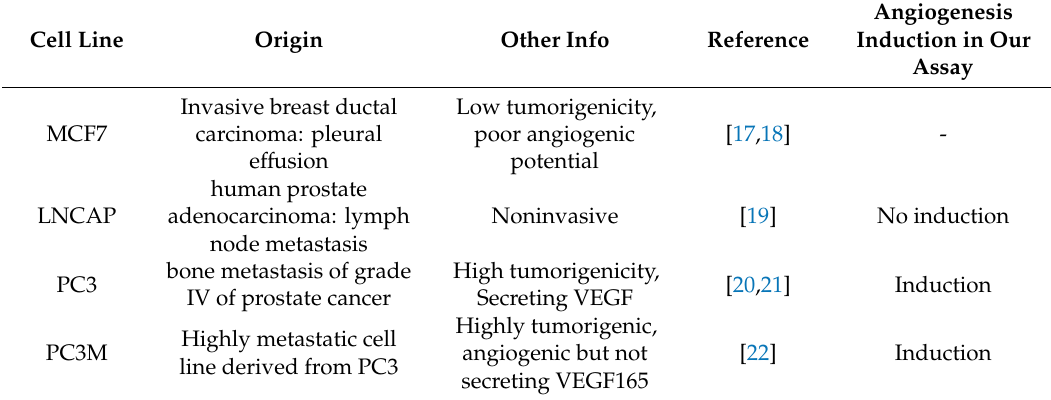
Figure 5. ( A ) Optimization of the angiogenesis induction test with PC3 and PC3M cells. Both show increased collagen IV induction compared to the vascular control ( B ) Optimized protocol without growth factors (GF) tested with PC3 and LNCAP cells. *** p < 0.05 and * p < 0.001. Table 1. Information about the cell lines used in the study and results obtained from the angiogenic induction potential test.